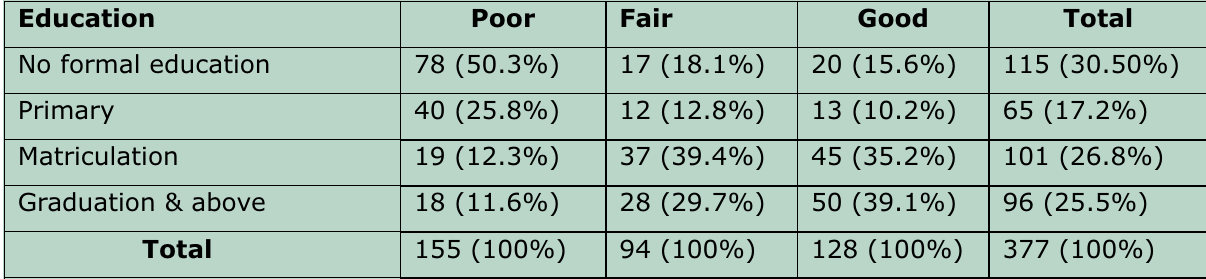
Table III: Husband's educational level and use of antenatal services.